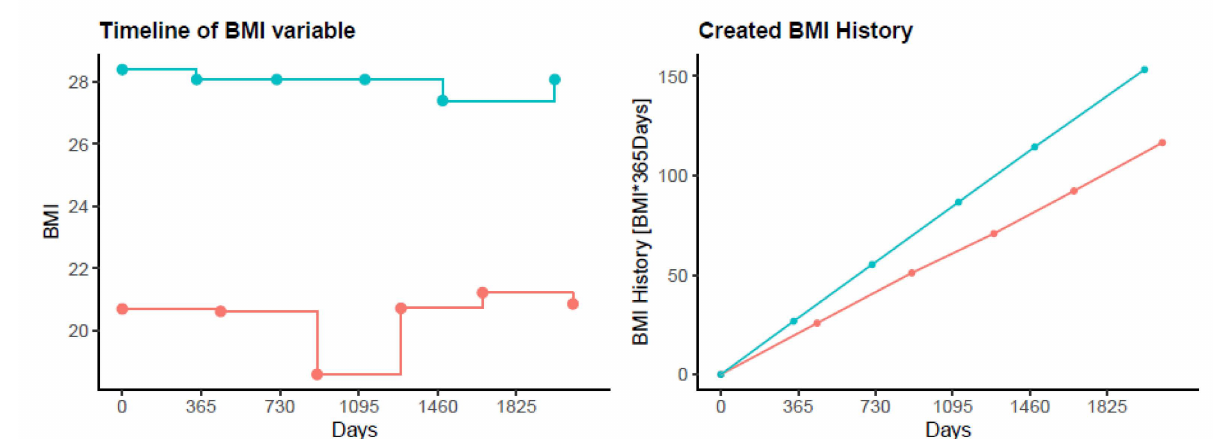
Figure 1. Example of the creation of a history variable. The longitudinally measured BMI variable presented on the left for two patients (red and blue) as an example for the construction of the history variable, which is presented on the right. The right plot represents the area under the curve from the left plot, summed up until the respective visits. The individual courses of BMI are therefore represented as the slope of the right curves.